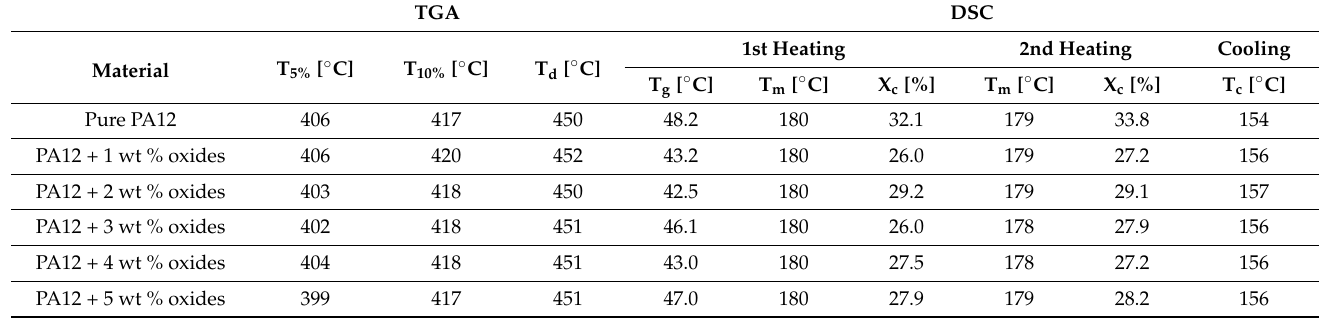
Table 4. The results of thermal analysis.